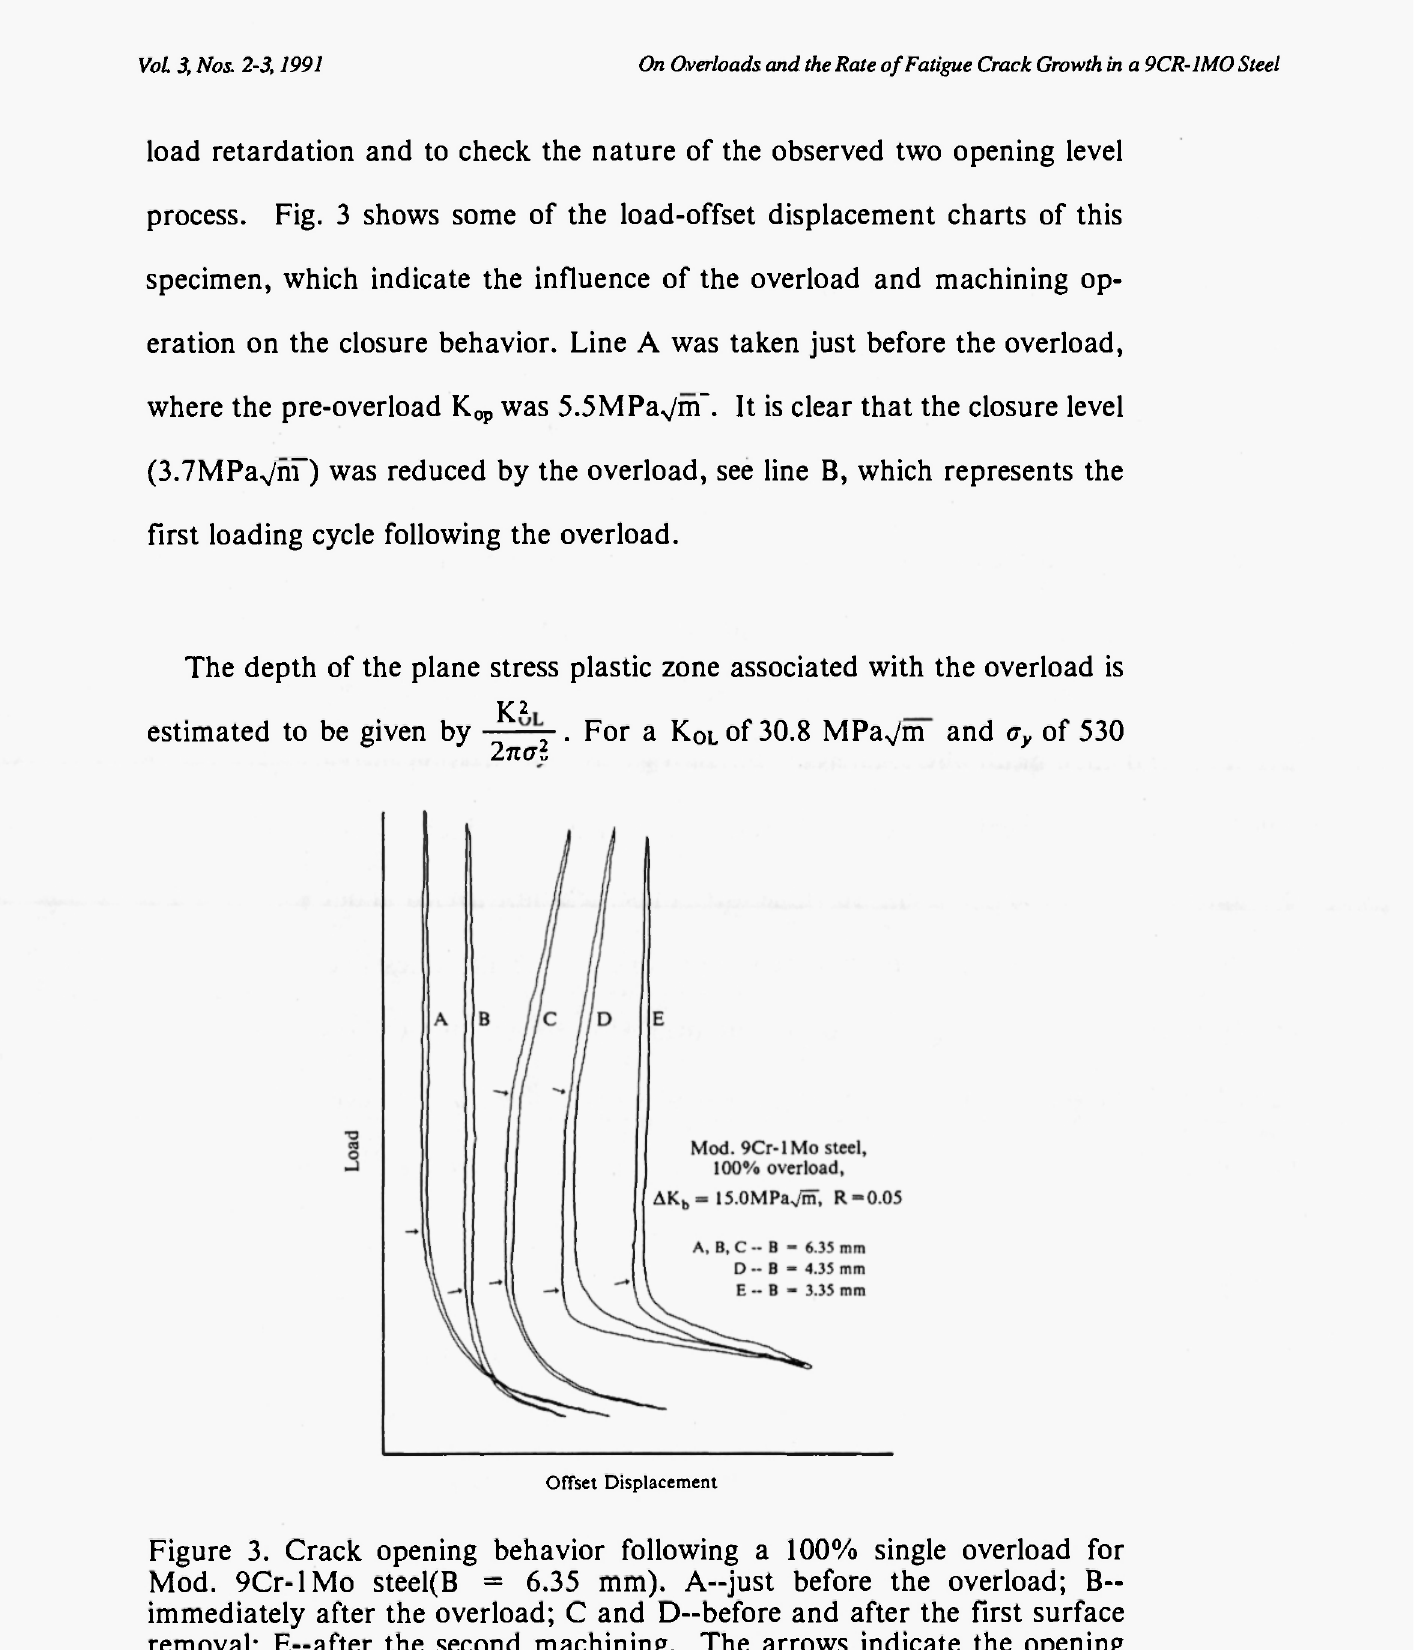
Figure 3. Crack opening behavior following a 100% single overload for Mod. 9Cr-lMo steel(B = 6.35 mm). Α-just before the overload; B-- immediately after the overload; C and D-before and after the first surface removal; E—after the second machining. The arrows indicate the opening